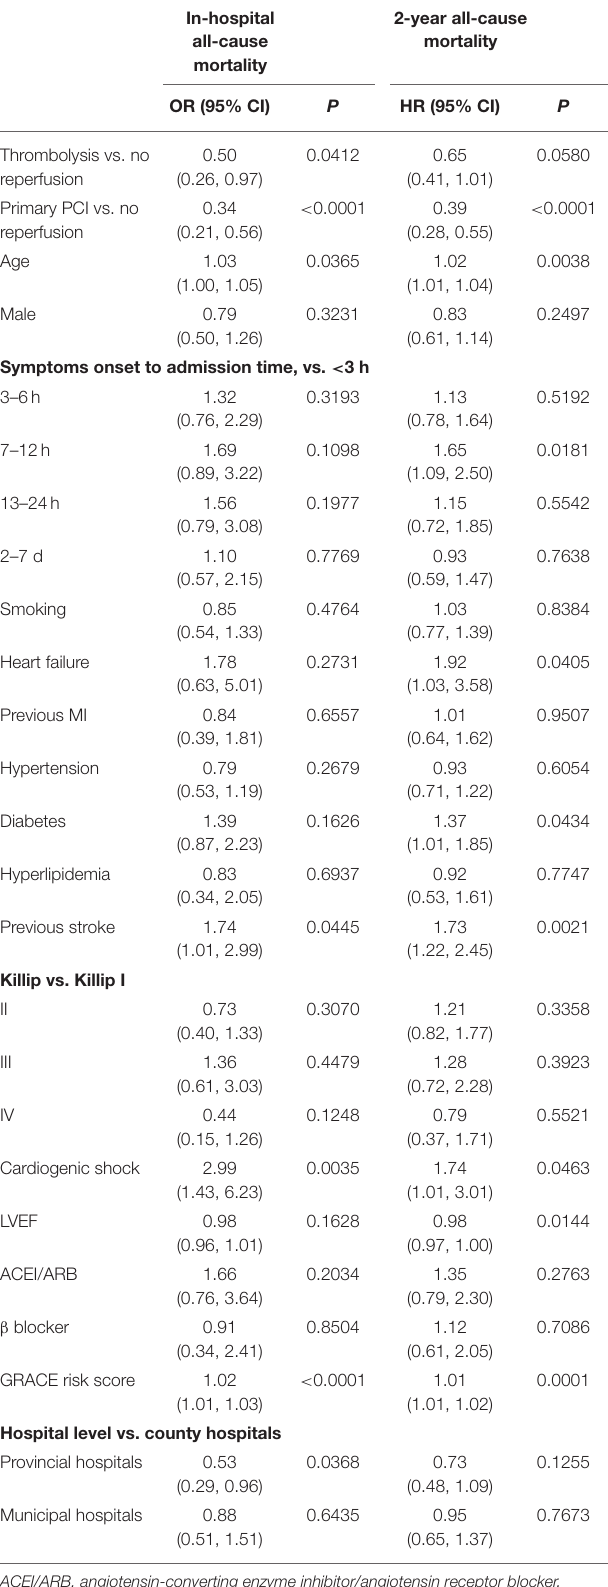
TABLE 3 | Independent predictors of in-hospital and 2-year all-cause mortality. In-hospital